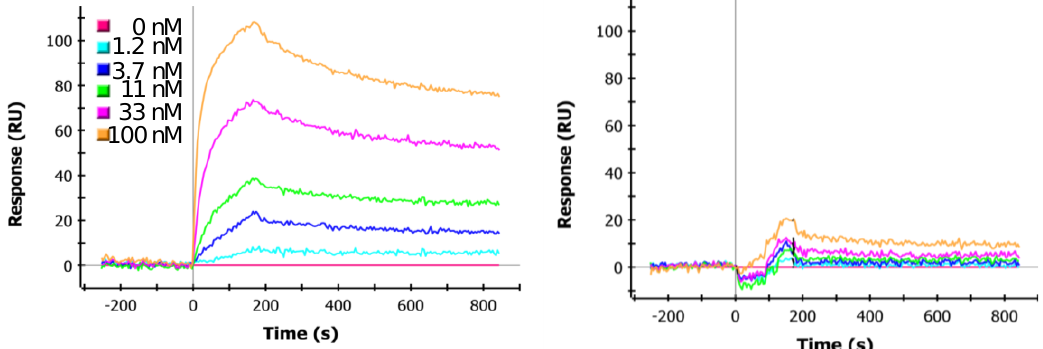
Figure 2. Sequential binding to ricin surface towards demonstrating simultaneous binding by sdAb in the H1-31-B4 construct. The left panel shows binding of a linked B4-31-B4 to a ricin surface that has been coated with sdAb-H1. The sdAb-H1 was applied over the ricin surface at a concentration of 100 nM for 3 min to approach saturation. Next the B4-31-B4 was applied in increasing concentrations as indicated on the figure. The right panel shows the B4-31-B4 applied to a ricin surface that had been coated with the H1-31-B4 construct to approach saturation using the same conditions as with the sdAb-H1. The same range of B4-31-B4 concentrations was applied.